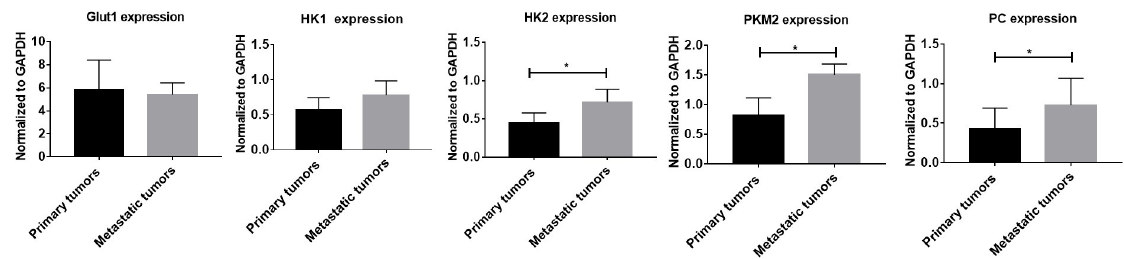
Figure 6. The glycolytic protein expression in primary tumors from the localized group and metastatic tumors from the metastatic group by Western blotting studies. Quantification of the expression of Glut1, HK1, HK2, PKM2, and PC protein by normalized to GAPDH expression. The significantly increased expression of HK2, PKM2, and PC protein in the metastatic tumors was shown. N = 3 in each group for Glut1, HK1 and HK 2, N = 4 in each group for PKM2, N = 5 in each group for PC, * p < 0.05.